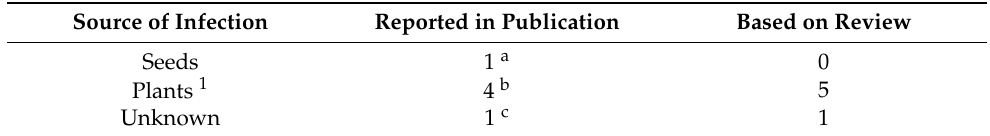
Table 7. Conclusions on the most probable source of pospiviroid infections in pepper crops as reported and drawn upon in the current review of the provided